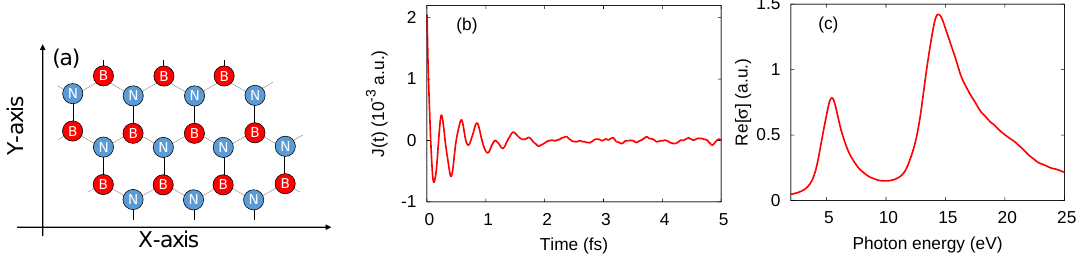
Figure 1. ( a ) atomic configuration of monolayer h -BN; ( b ) current density in time domain after the impulsive distortion at t = 0; ( c ) real-part of surface conductivity, (cid:60) [ σ ( ω )] , of h -BN, calculated by TDDFT with